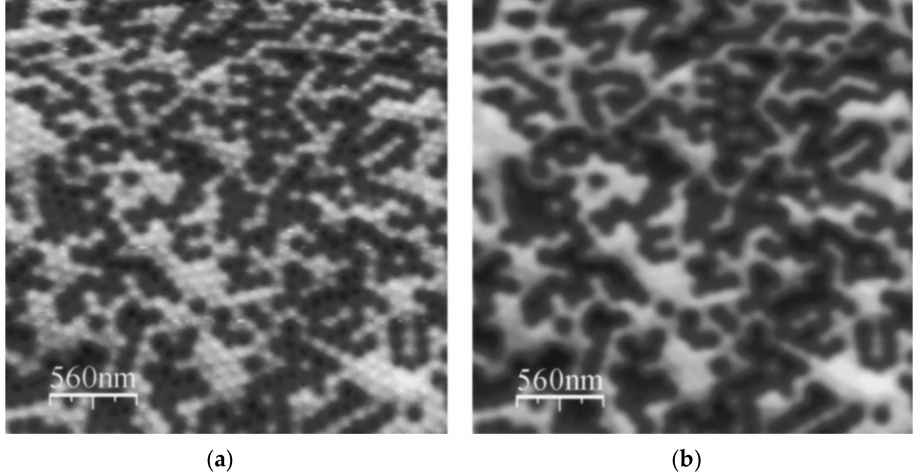
Figure 2. ( a ) MFM image of a Ni nanowire array at remanence measured with the aforementioned tip diameter; ( b ) simulated MFM image of the same MFM data for an assumed tip with a magnetic domain size of 140 nm. Image size: 2.8 µ m × 2.8 µ m. Reprinted from [44], with permission from